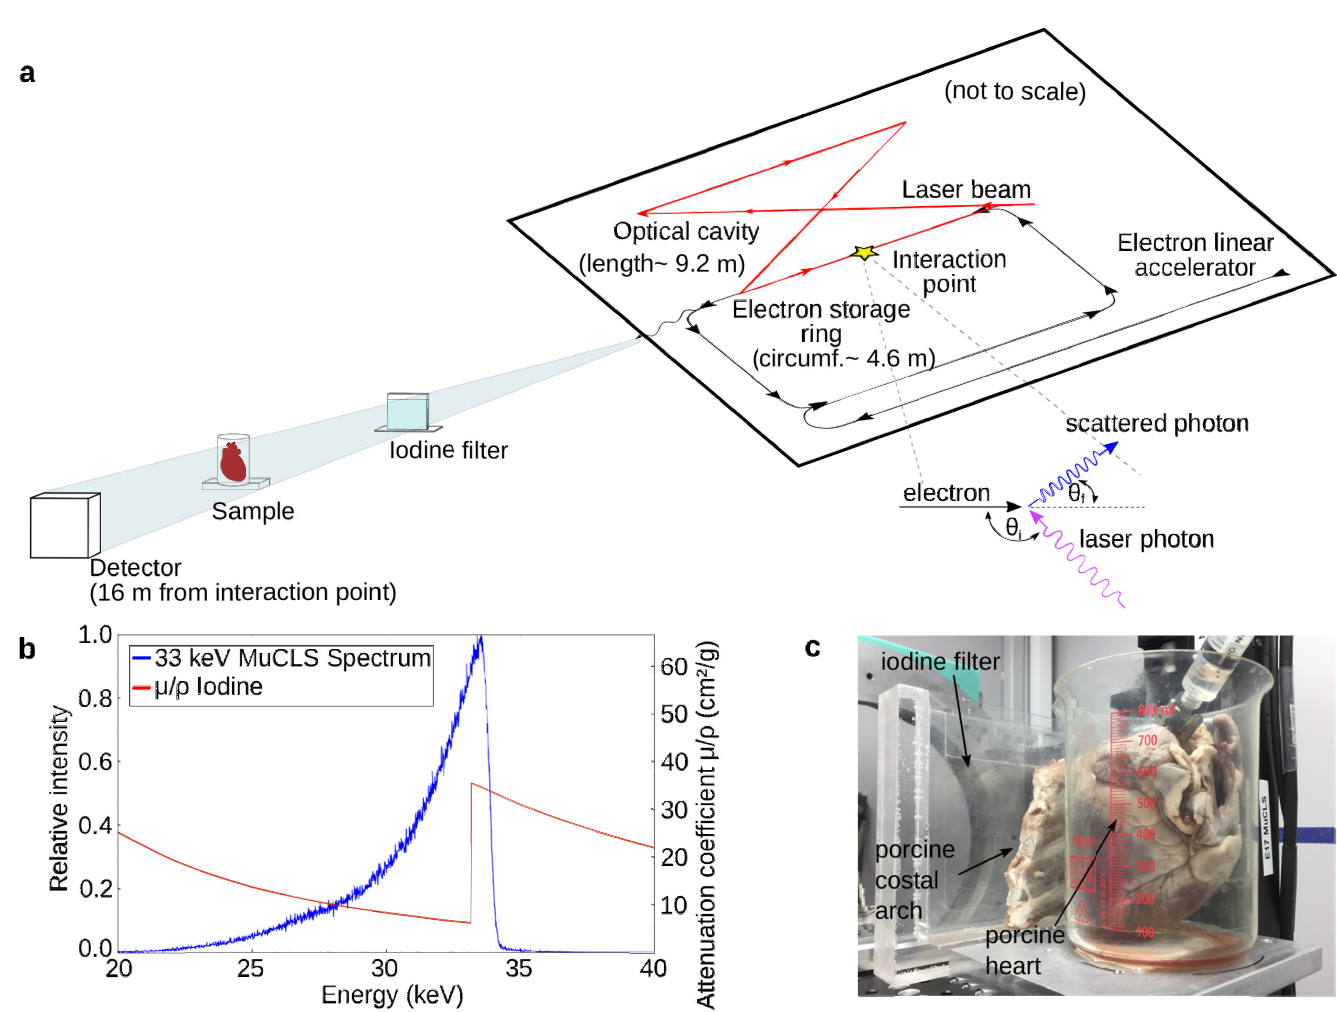
Fig 1. (a) Schematic of the experimental set-up at the Munich Compact Light Source (MuCLS): X-rays are produced at the interaction point of laser photons stored in the optical cavity and relativistic electrons circulating in the storage ring. These propagate in a vacuum tube to the experiment at a source-to sample distance of 15.5 m. The detector is located at a distance of 16 m from the interaction point. (b) X-ray spectrum with the peak energy tuned to 33.49 keV measured with a KETEK AXAS-D detector, shown together with the iodine attenuation coefficient. (c) Photograph of the experimental set-up showing the iodine filter in front of a porcine coastal arch and a porcine